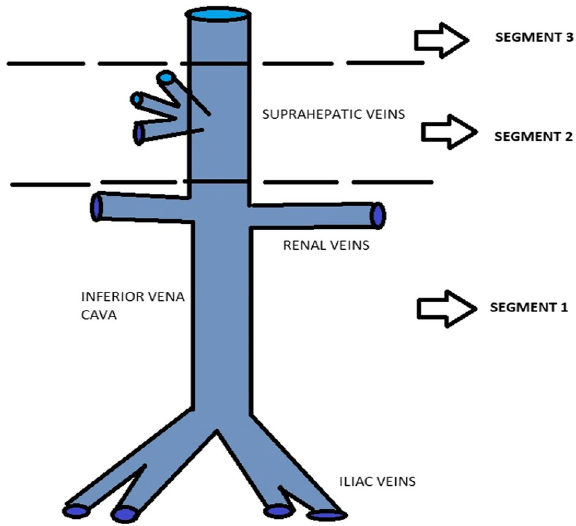
Fig. 3 Mingoli’s anatomical classification of IVC